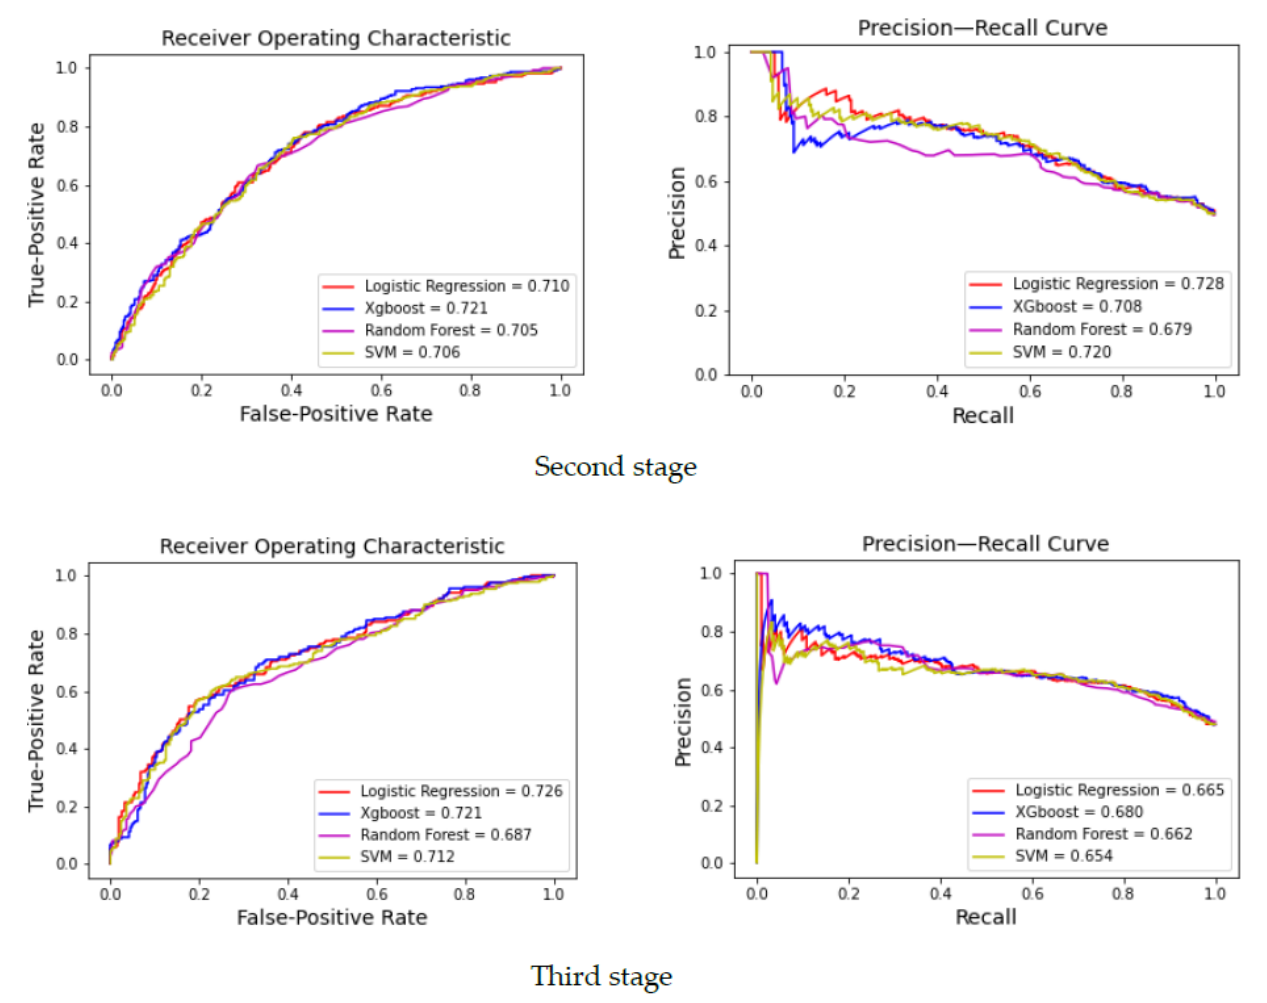
Figure 3. ROC and PRC curves for the machine learning models with concurrence designs.